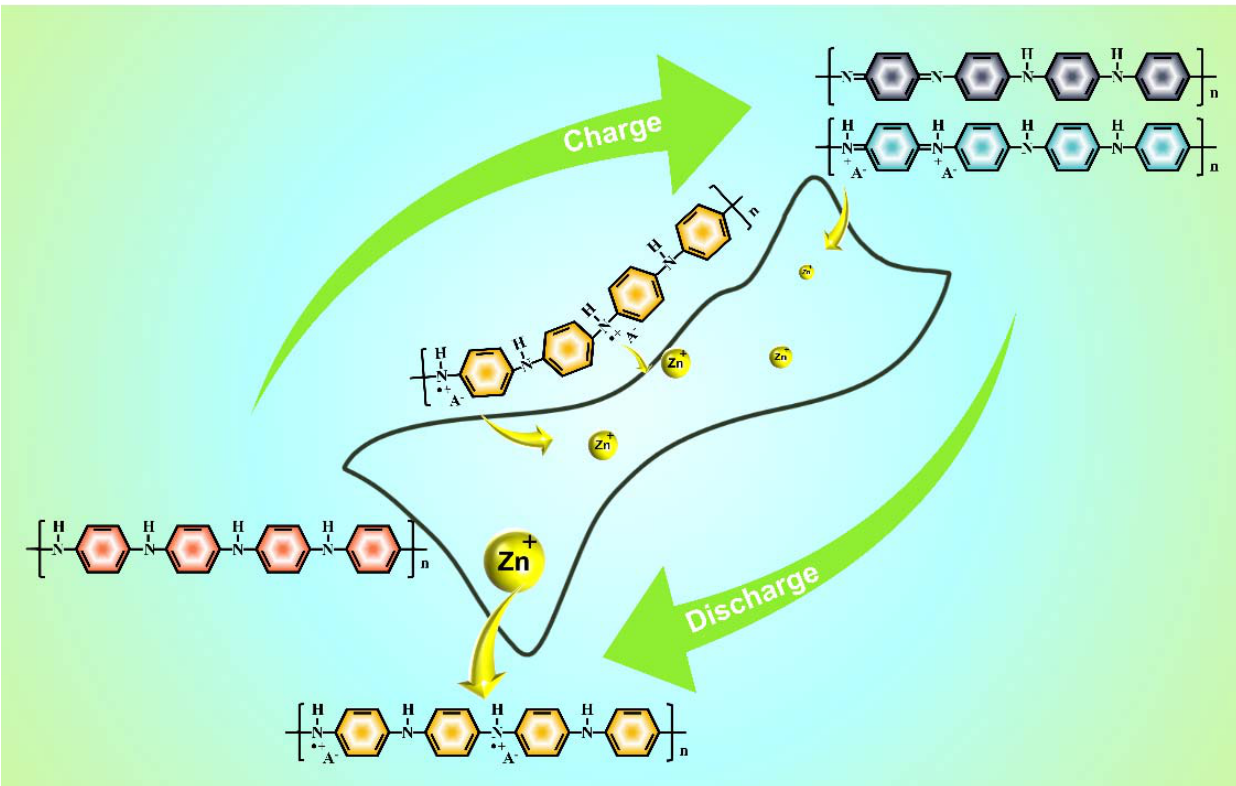
Figure 6. Diagram showing the sequential transformation of protonated and non ‐ protonated PANI.